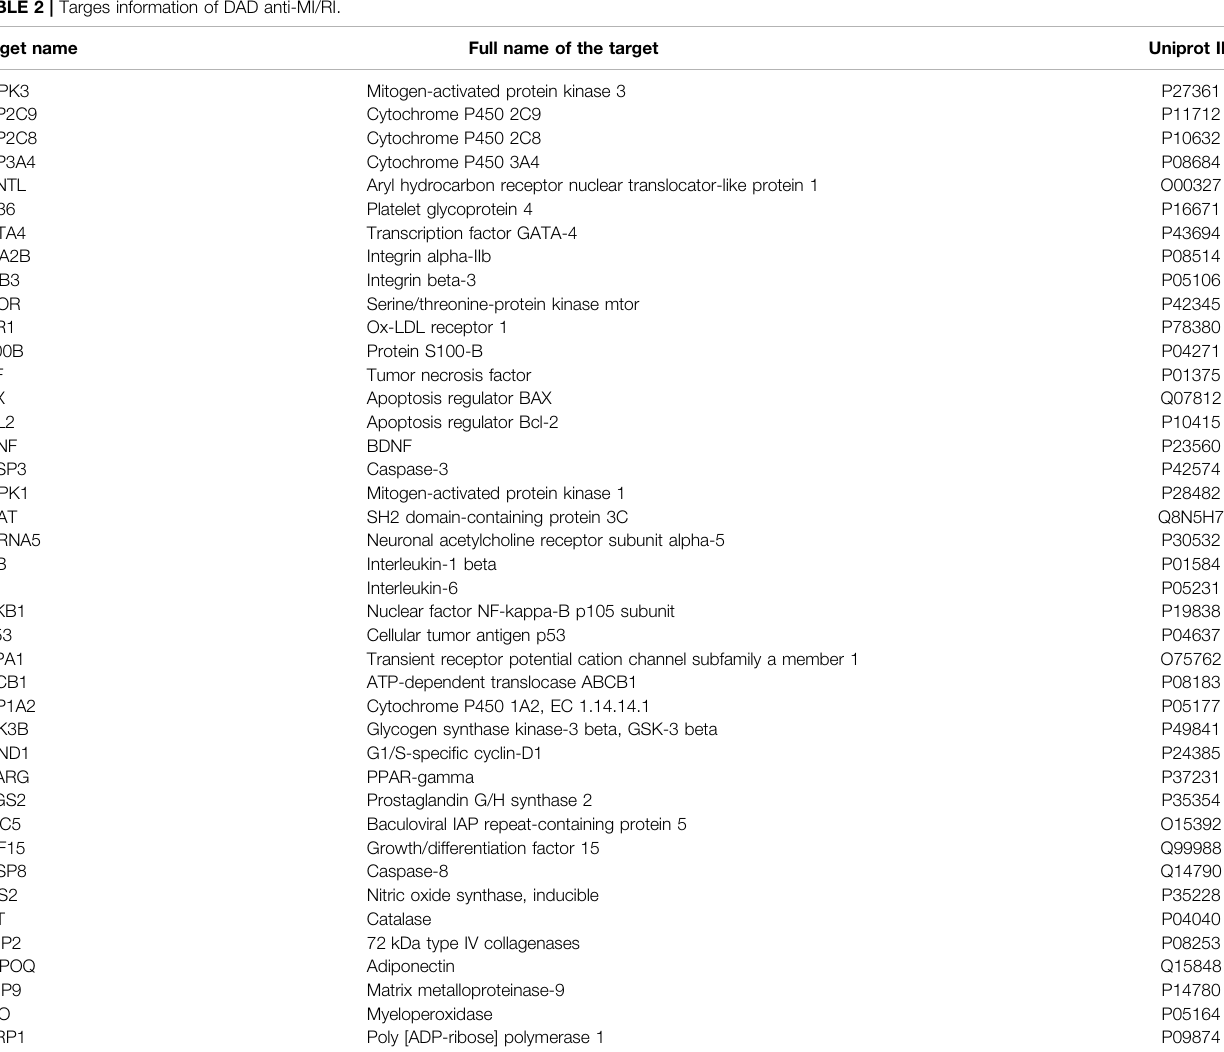
TABLE 2 | Targes information of DAD